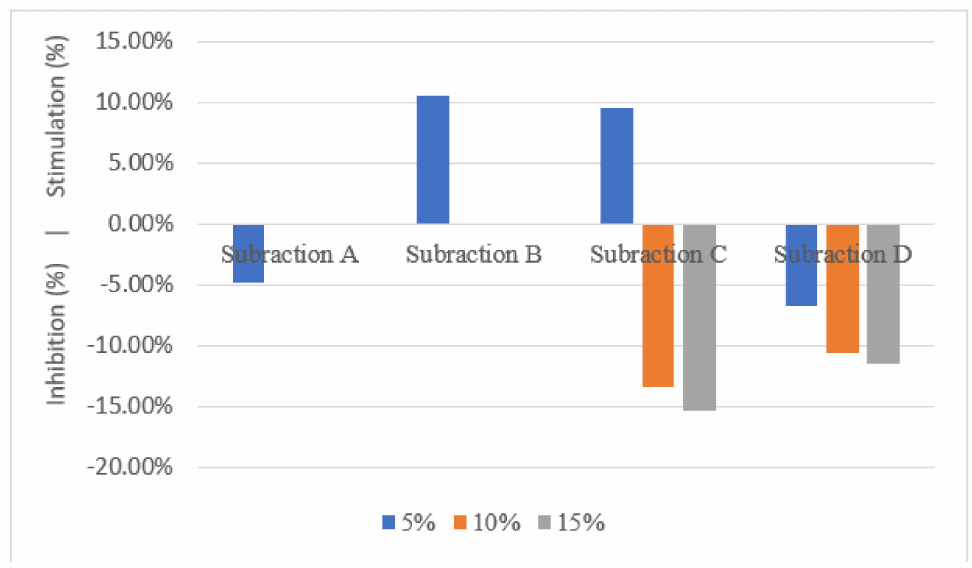
Figure 5. Effect of ethyl acetate A. conyzoides extracts at different subfractions on root length of A. spinosus at 21